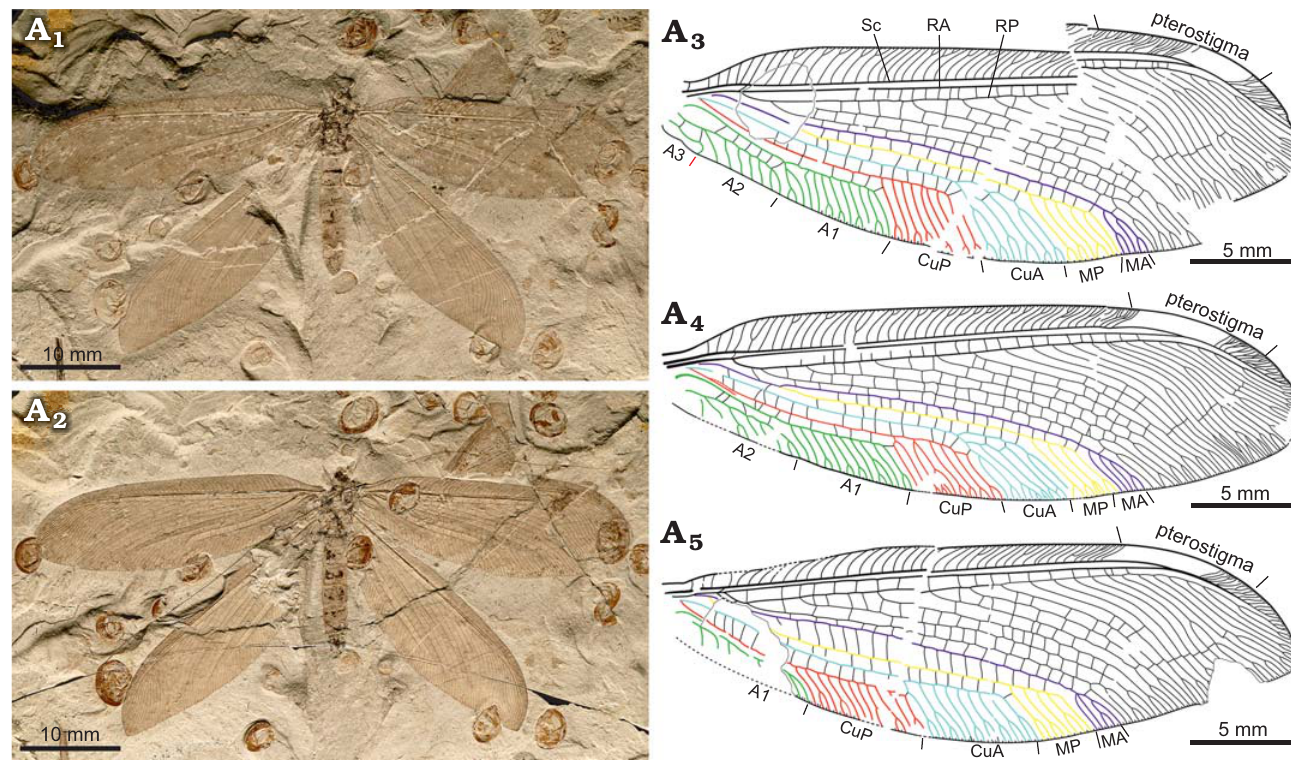
Fig. 1. Lance lacewing Vetosmylus tentus gen. et sp. nov. (holotype, CNU − NEU − NN2019001P/C) from Aalenian–Bajocian boundary (Middle Jurassic) of Jiulongshan Formation of Daohugou, China. Photographs of part (A 1 ) and counterpart (A 2 ). Line drawings of left forewing (A 3 ), right forewing (A 4 ), left hind wing (A 5 ). Abbreviations: A, anal veins; CuA/P, anterior/posterior cubitus; MA/P, anterior/posterior branch of media; RA/P, anterior/posterior branch of radius; Sc,